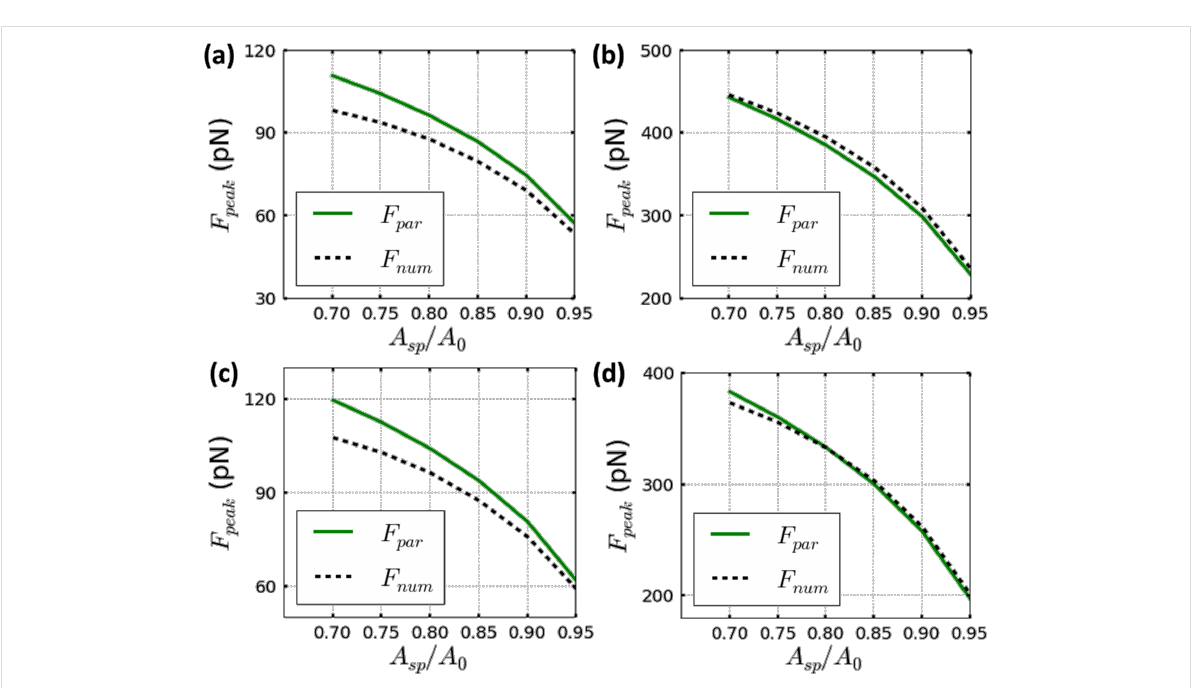
Figure 4: The dependence of the peak forces on the set-point amplitude for the parametrical equation of Equation 8 (full line plots) and the corre- sponding numerical simulations for Tatara’s contact mechanics (dashed line plots). (a) Material with a Young’s modulus of 200 MPa and A 0 = 1 nm. (b) Material with the same Young’s modulus as (a) and a higher free amplitude A 0 = 4 nm. (c) Material with a Young’s modulus of 300 MPa and A 0 = 1 nm. (d) Material with the same Young’s modulus as (c) and a higher free amplitude A 0 = 4 nm. Parameters are: Q = 2, k = 0.1 N/m and R t = 5